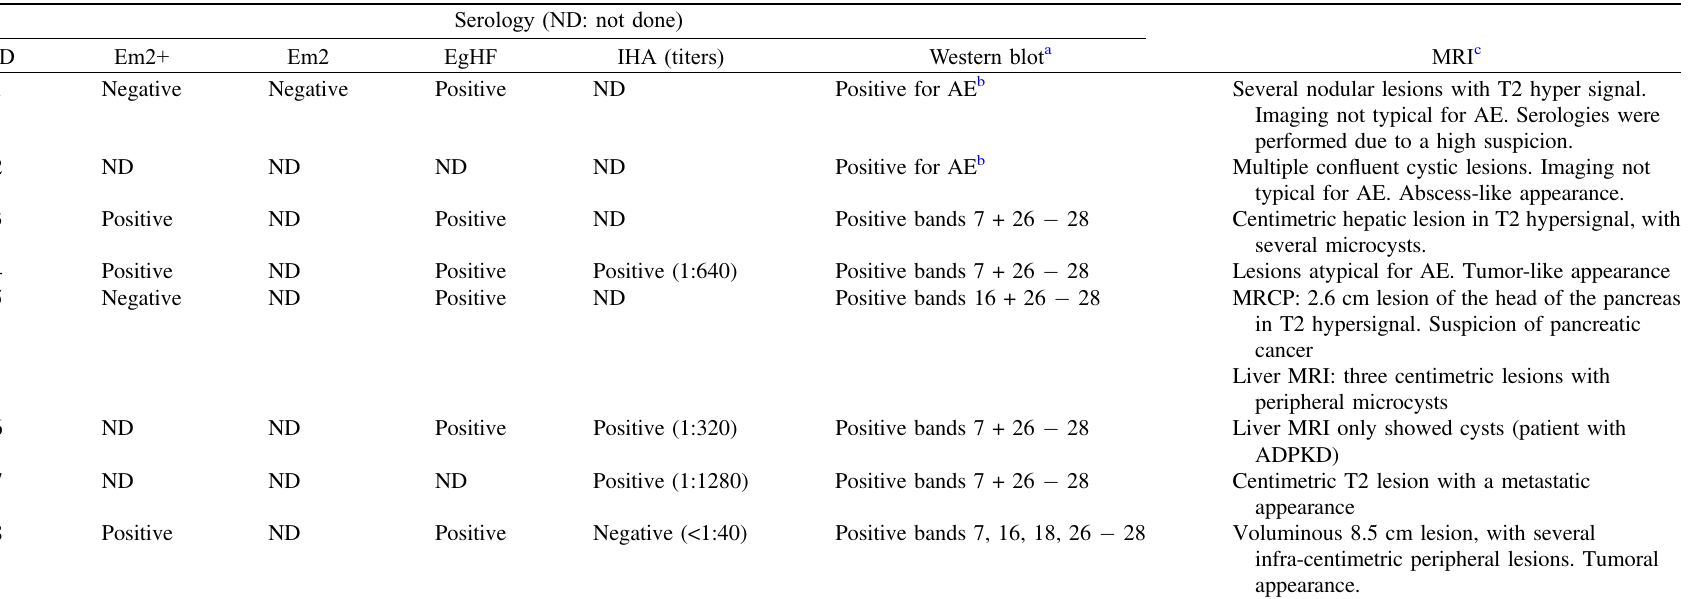
Table 2. Diagnosis of alveolar echinococcosis (AE) in patients with solid organ transplantation. Serology (ND: not